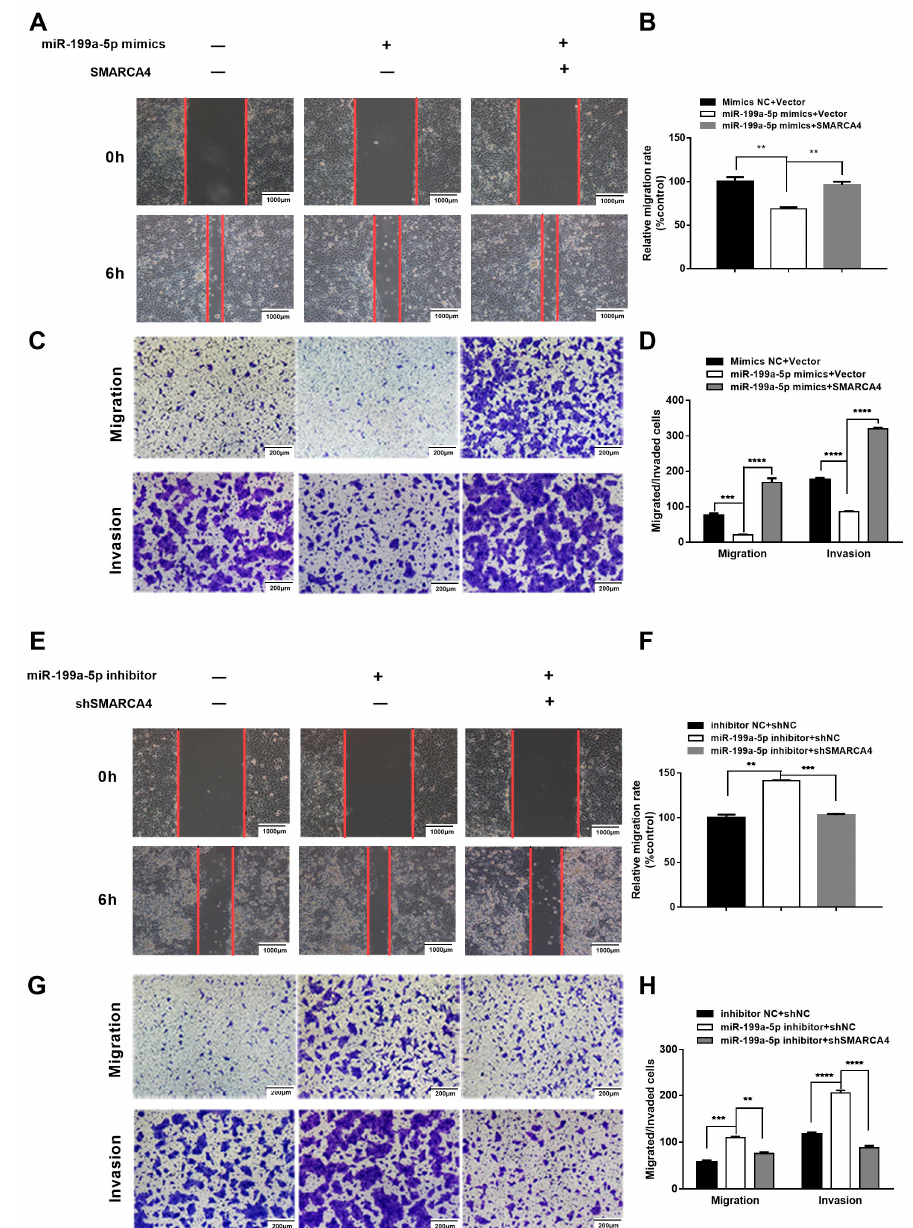
Figure 7. miR-199a-5p inhibits OSCC cell migration and invasion through the downregulation of SMARCA4. ( A – D ) The effect of SMARCA4 overexpression on miR-199a-5p mimics-induced OSCC cell migration and invasion inhibition. SAS cells were transfected with miR-199a-5p mimics, or miR-199a-5p mimics and SMARCA4 overexpression plasmid. Cell migration was measured by both the wound healing assay ( A ) and Transwell migration assay ( C ), and cell invasion was measured by the Transwell invasion assay ( C ). Quantitative analysis was performed by the Image J software ( B , D ). ( E – H ) The effect of SMARCA4 inhibition on miR-199a-5p inhibitor-induced OSCC cell migration and invasion. SAS cells were transfected with miR-199a-5p inhibitor, or miR-199a-5p inhibitor and sh-SMARCA4. Cell migration was measured by both the wound healing assay ( E ) and Transwell migration assay ( G ), and cell invasion was measured by the Transwell invasion assay ( G ). Quantitative analysis was performed by the Image J software ( F , H ). The scale bar is shown in lower-right corner. Data are expressed as the mean ± SEM from triplicate experiments. ** p < 0.01, *** p < 0.001, **** p < 0.0001, comparison with the corresponding